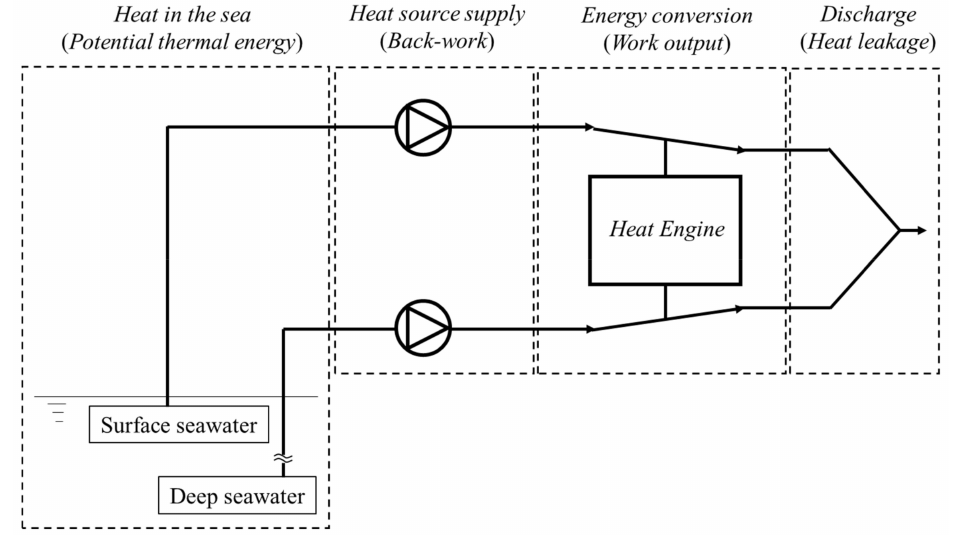
Figure 2. Conceptual process flow in OTEC power generation. The process consists of four parts: heat in the sea, heat source supply, energy conversion, and